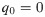
Initialization of CEL.(a) q0=0. (b) q0=2 (squares represent the base station, triangles represent p-nodes, hollow circles represent d-nodes to be filled, and solid circles represent filled d-nodes).